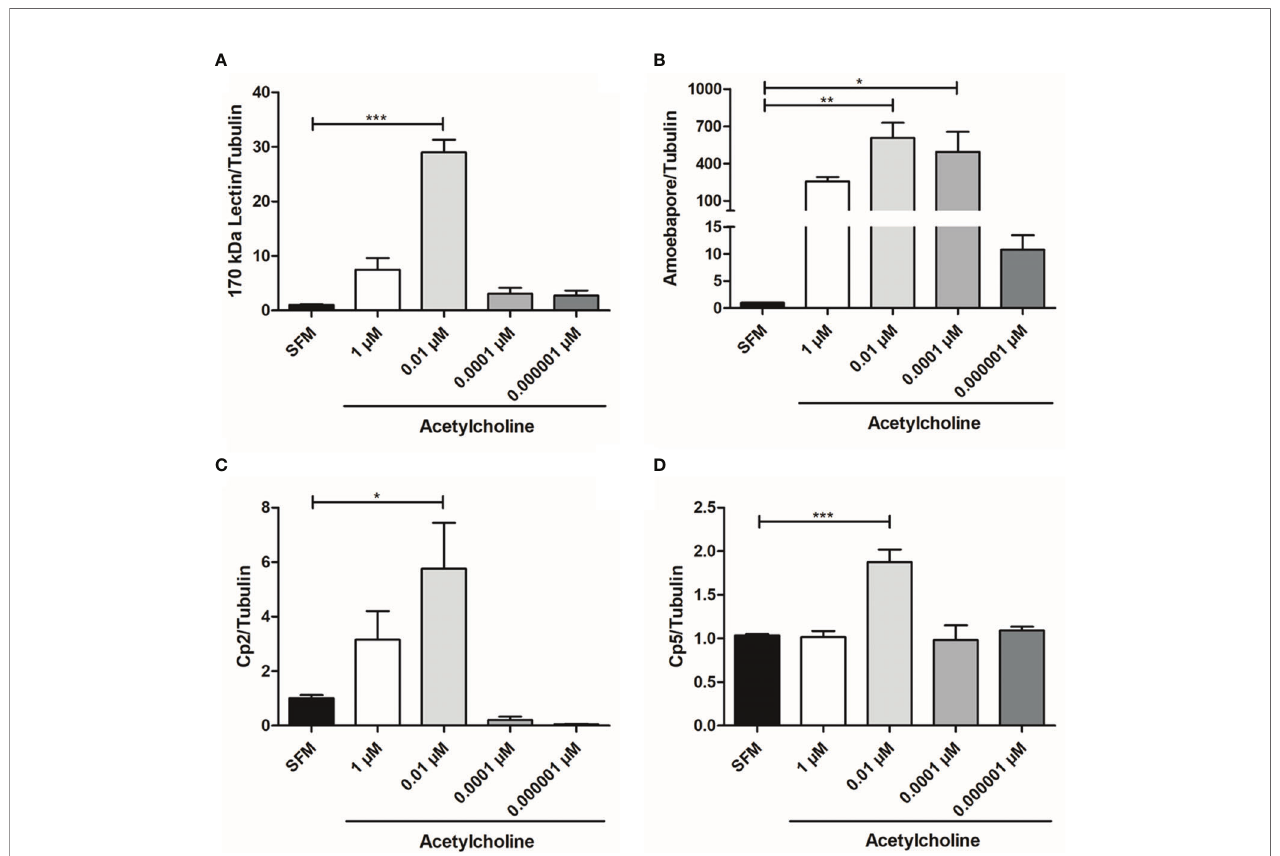
FIGURE 3 | Acetylcholine upregulates E. histolytica virulence factors expression. Relative expression of the (A) Gal/GalNAc lectin heavy subunit, (B) Amebapore , (C) ehcp-a 2 and (D) ehcp-a 5 by RT-qPCR ampli fi cation from treated trophozoites with different concentrations of ACh for 1 h. Relative expression levels normalized with constitutive gene a -tubulin . Data correspond to the mean ± SEM of three independent experiments (n = 3). The statistical analysis was performed with the one- way ANOVA and Tukey posttest method, where the values of *p < 0.05, **p < 0.01 and ***p < 0.001 were considered signi fi